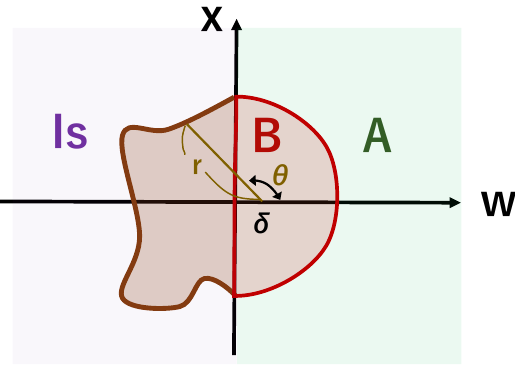
Figure 6 . Island setup in BCFT 3